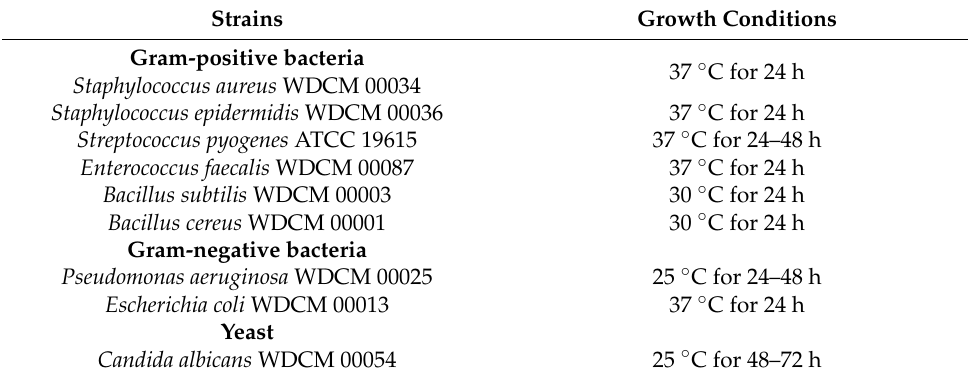
Table 6. Strains used for the assay and growth